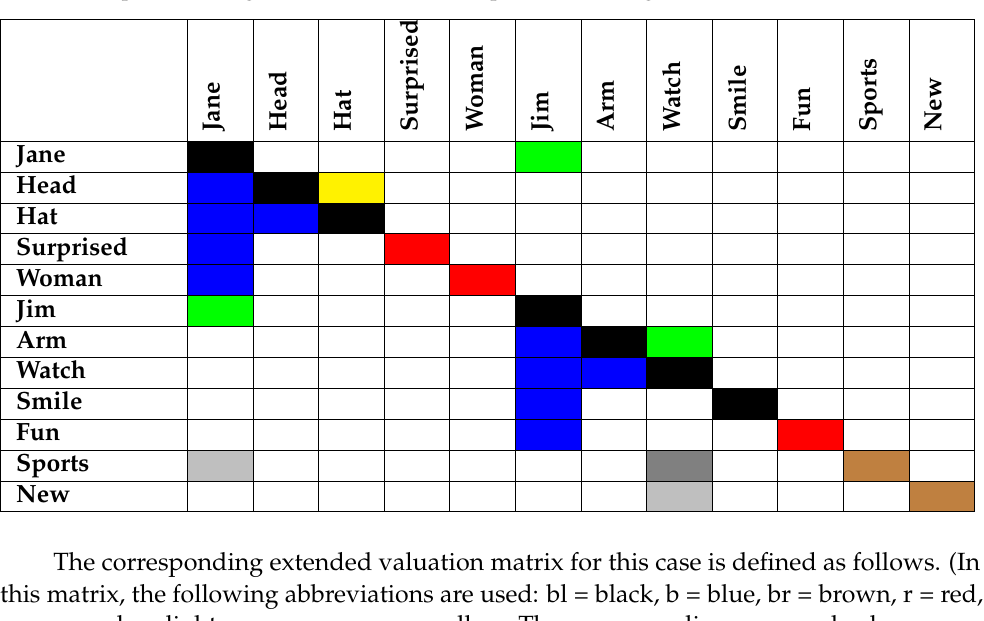
Table 1. Graph code image for the MMFVG example shown in Figure